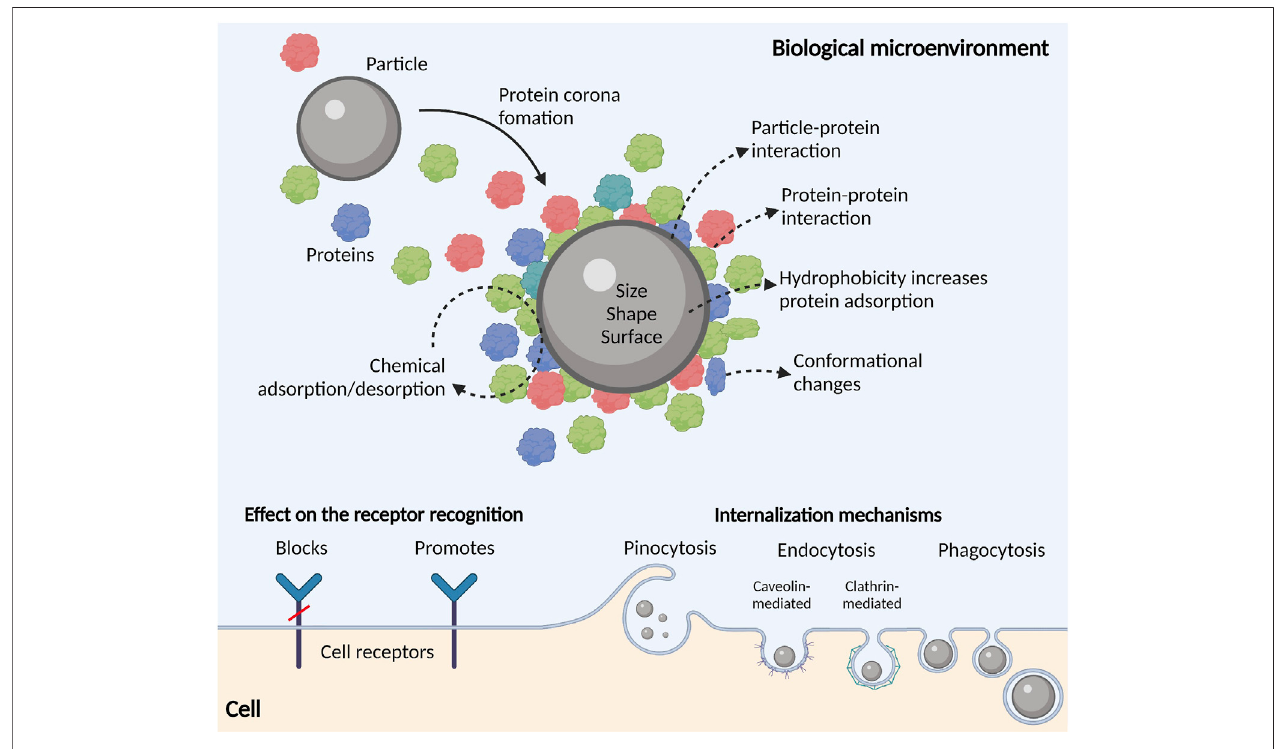
FIGURE5| Particle ’ sbiologicalidentity.Particles enteringprotein-richbiologicalenvironmentsareswiftly covered byproteins forming theso-calledprotein corona or mechanical interface between particles and cell receptors. Particle physicochemical properties are directly dictating the composition of the protein corona and the extenttowhichproteinsadsorb/desorbfromtheparticle ’ ssurface.Theproteincoronamayblockorpromotereceptorrecognitionandparticleinternalizationbythecells. Particle ’ s size determines the mechanism of the internalization, and it may involve pinocytosis, endocytosis (caveolin- or clathrin-mediated) and phagocytosis.